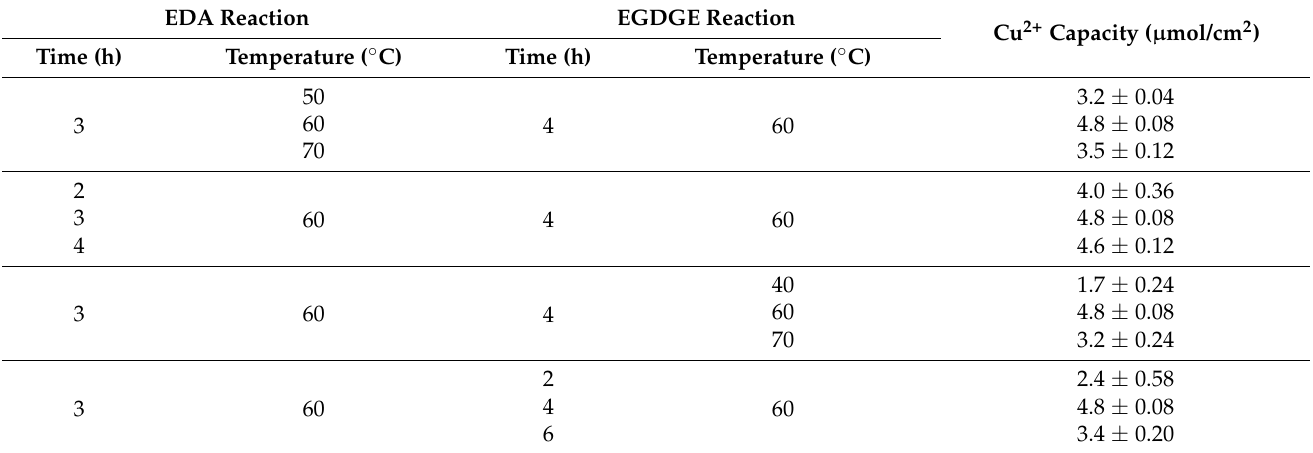
Table 1. The results of immobilized copper ions capacity on IMAM under various EDA and EGDGE reaction conditions (based on the use of 0.2 M IDA and 0.05 M CuSO 4 in the subsequent reactions) via UV-Vis at 800